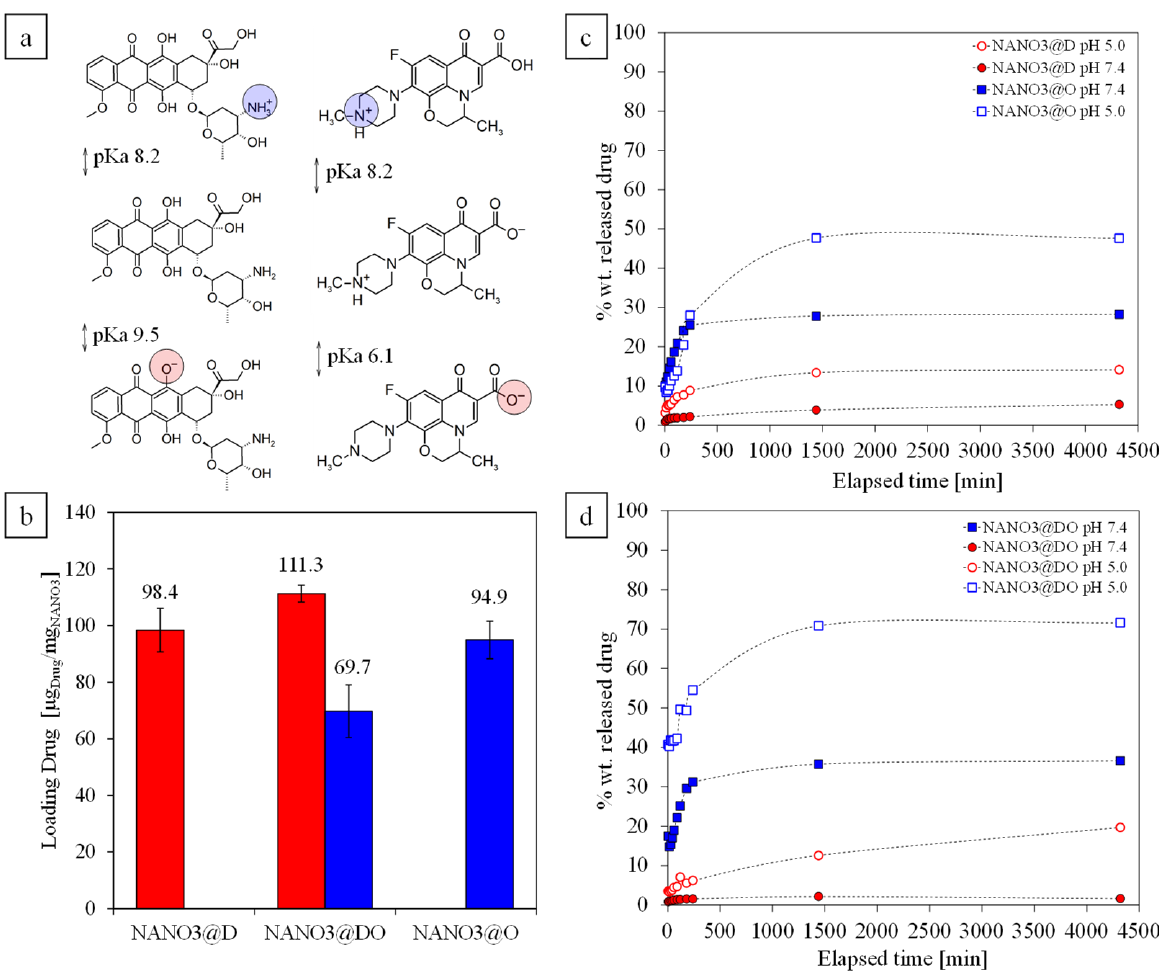
Figure 4. Ionization of DOX and OFLO in aqueous solutions ( a ). NANO3 systems loading capacities of DOX and OFLO (n = 5), in single and dual combinatory formulations ( b ). DOX (circles) and OFLO (squares) release profiles from NANO3@D and NANO3@O ( c ) as well from NANO3@DO and ( d ) under physiological and acidic conditions (n = 3).